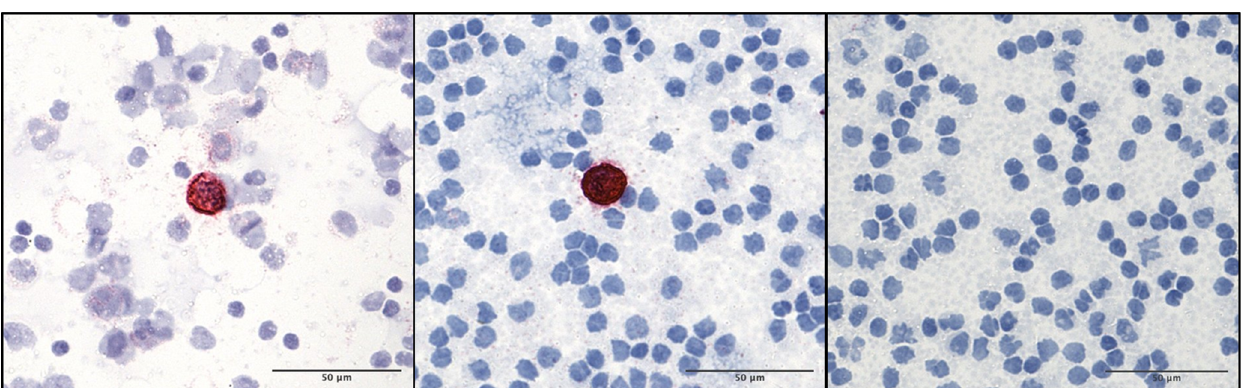
Figure A2. Quantification of disseminated tumor cells (DTCs) in patients with bone marrow aspi- ration before ( left ) and after chemotherapy ( right ). Samples were classified as DTC-negative (0 DTCs/1.5 × 10 6 mononuclear cells) or DTC-positive ( ≥ 1 DTC/1.5 × 10 6 mononuclear cells OR ≥ 2 DTCs/1.5 × 10 6 mononuclear cells OR ≥ 4 DTCs/1.5 × 10 6 mononuclear cells OR ≥ 5 DTCs/1.5 × 10 6 mononuclear cells).